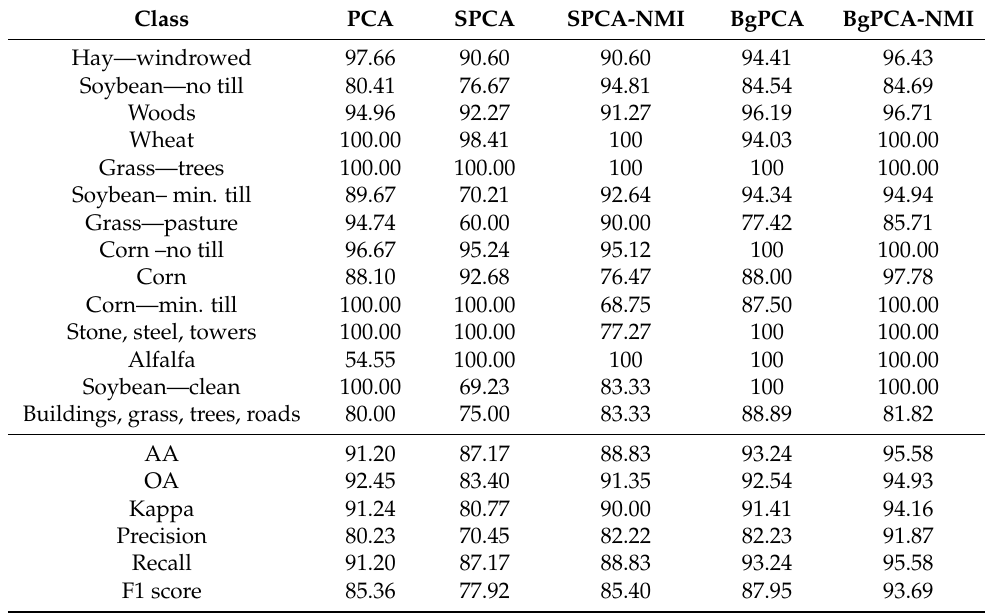
Table 5. Detailed classification outcomes for the Indian Pines dataset.